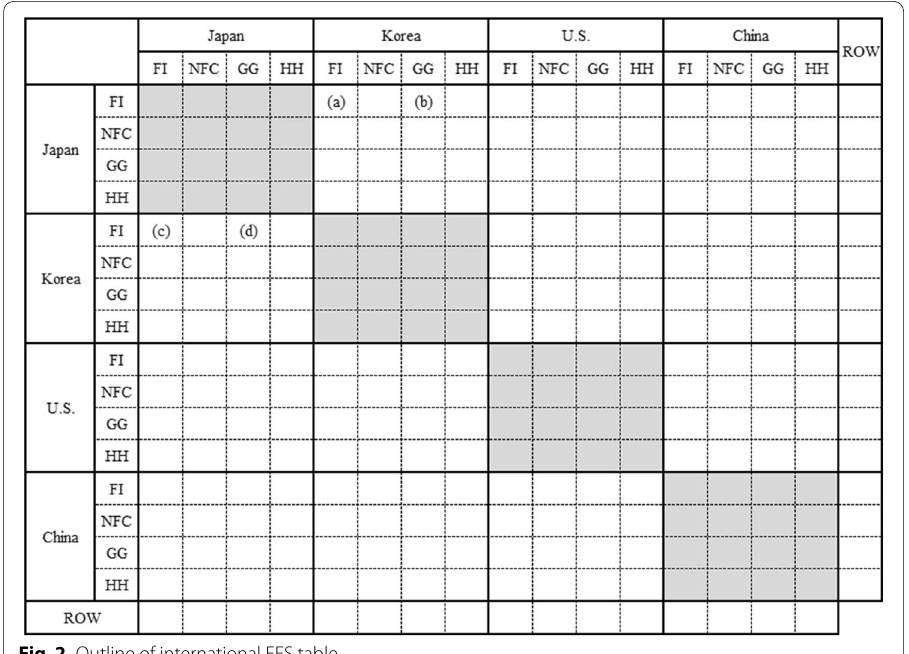
Fig. 2 Outline of international FFS